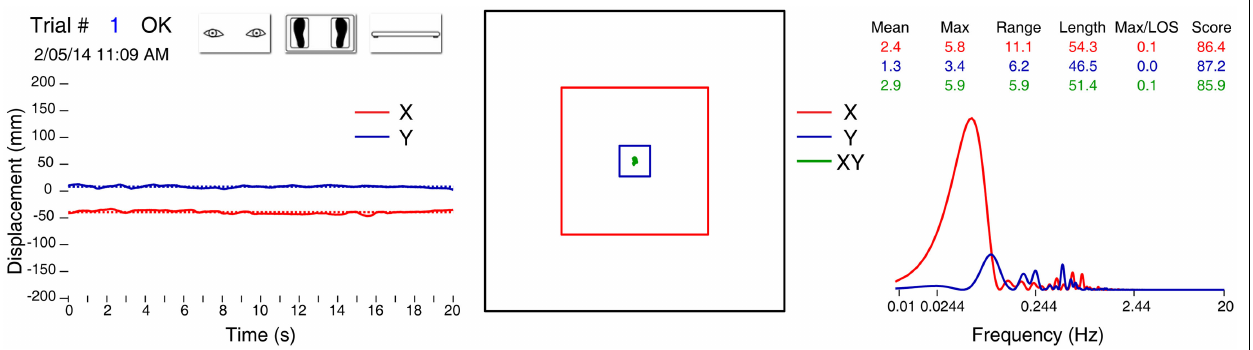
statokinesigram (green trace), limit of normality (small blue square), and limit of stability (larger red square). On the right: table of several variables and graph of the Fourier analysis.